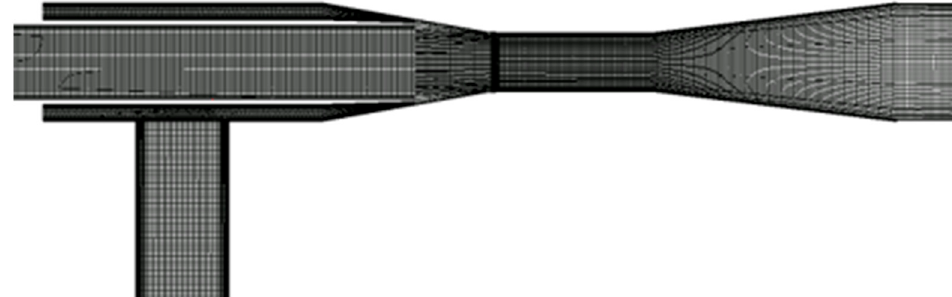
Figure 6. Numerical grids of annular jet pump model.